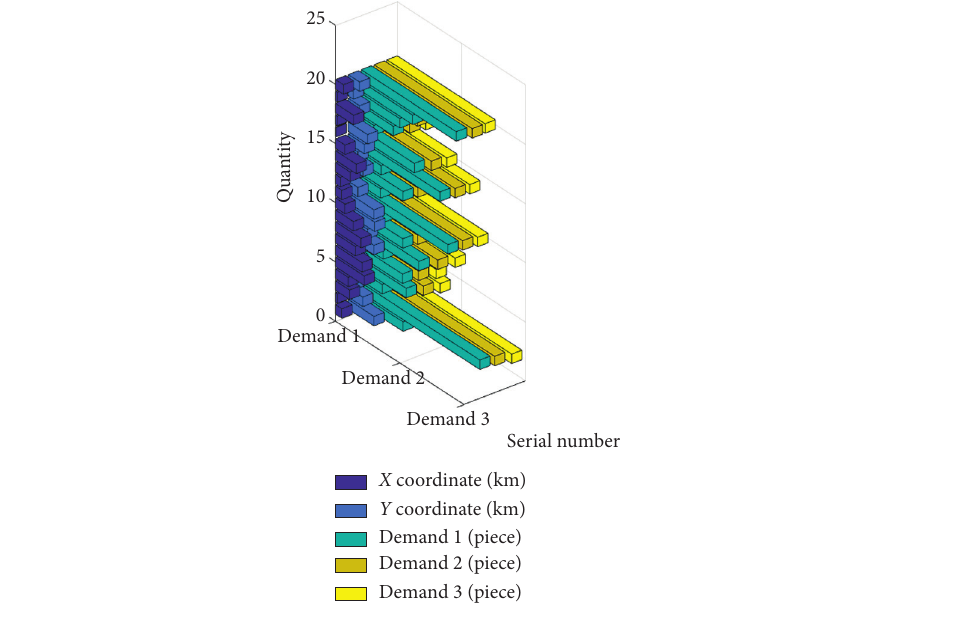
Figure 3: Data of emergency supplies demand points. Table 3: Data from emergency supplies vehicles.